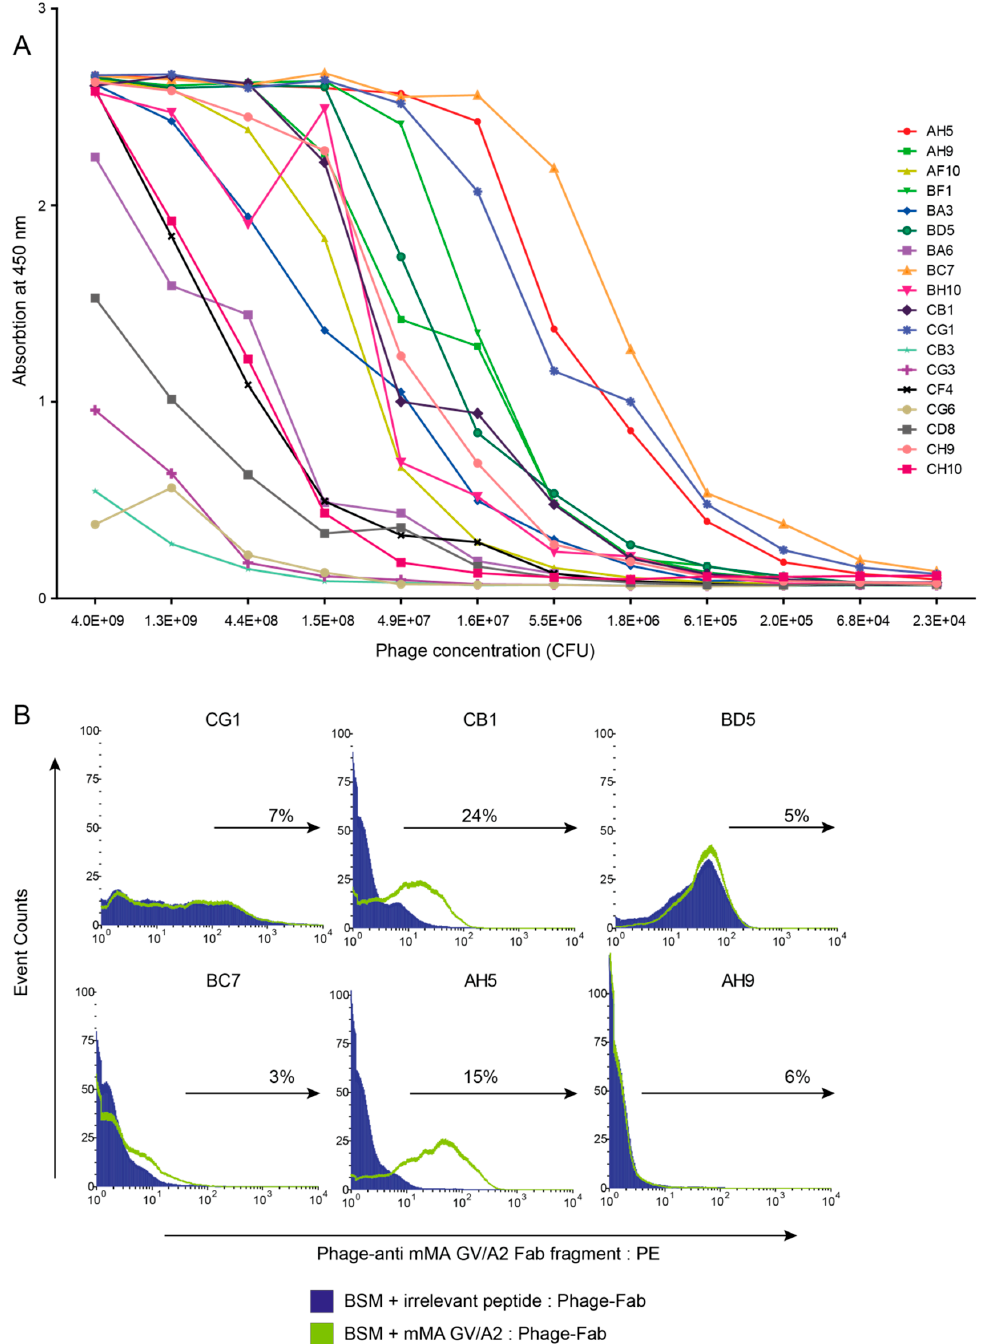
Figure 2. Characterisation of phage-antibody clones for binding to mMA peptides. ( A ) Streptavidin plates were coated with biotinylated soluble mMA-GV/A2. Eighteen phage-antibodies were selected and incubated with titrated amounts of pMHC complexes, and binding was detected per ELISA. A representative example is shown out of two independent experiments. ( B ) Six binders from A were tested for binding towards BSM cells pulsed with mMA-GV or irrelevant peptide by flow cytometry. Data are presented as histograms and percentages in plots indicate binding towards BSM cells loaded with mMA-GV peptide corrected for irrelevant peptides.